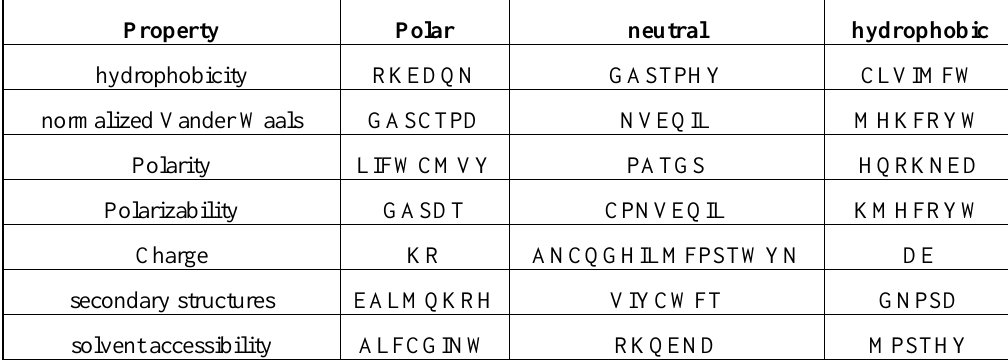
Table 2: Distribution situation of amino acid properties